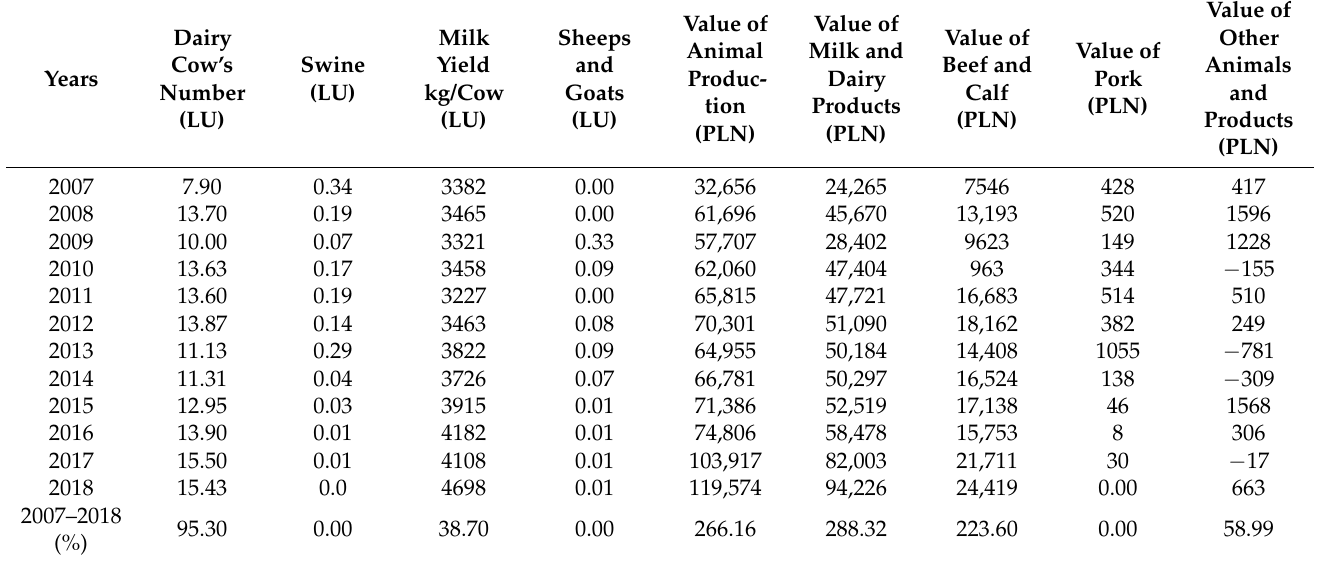
Table 7. Characteristics of animal production of dairy organic farms in Poland in